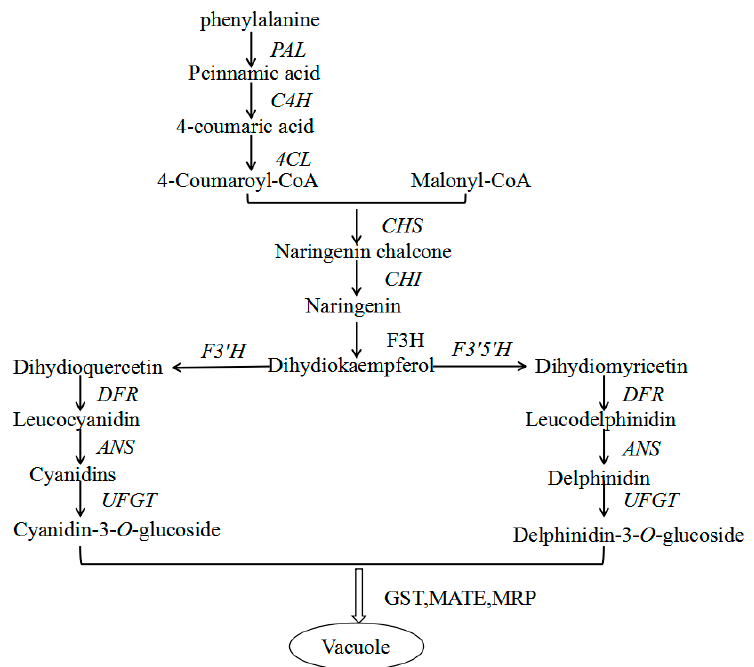
Figure 6. Anthocyanin biosynthetic pathway. Abbreviations: PAL , phenylalanine ammonia lyase; C4H , cinnamate-4-hydroxylase; 4CL , 4-coumaroyl-coA synthase; CHS , chalcone synthase; CHI , chalcone isomerase; F3 (cid:48) H , flavonoid-3 (cid:48) -hydroxylase; F3 (cid:48) 5 (cid:48) H , flavonoid-3 (cid:48) 5 (cid:48) -hydroxylase; F3H , flavanone-3- hydroxylase; DFR , dihydroflavonol 4-reductase; ANS , anthocyanidin synthase; UFGT , flavonoid-3-O- glucosyltransferase; GST, glutathione S-transferase; MATE, toxic compound extrusion; MRP, multidrug resistance-associated